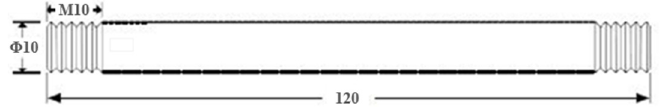
Figure 1. Dimensions of tensile test specimens at high temperature.